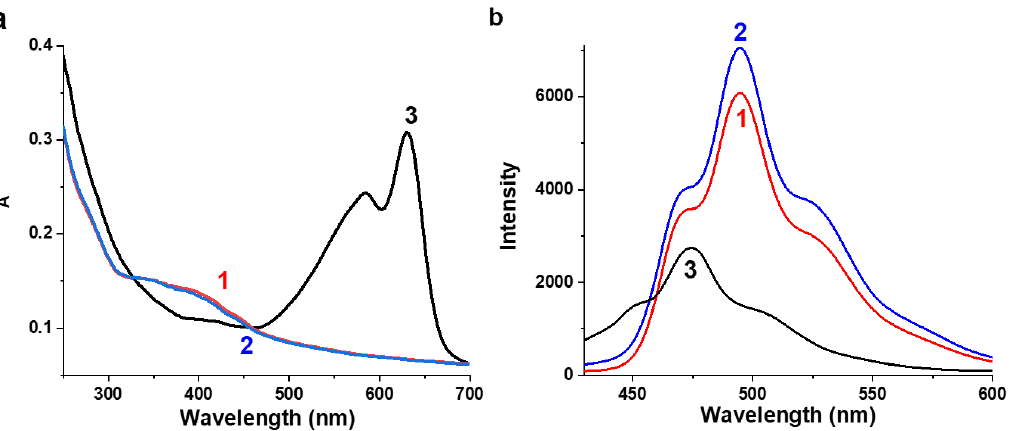
Figure 2. Electronic absorption ( a ) and emission spectra ( b ) of HCur -PC (C HCur = 0.041), HCur -PS (C HCur = 0.036) and HCur -PDA (C HCur = 0.011).